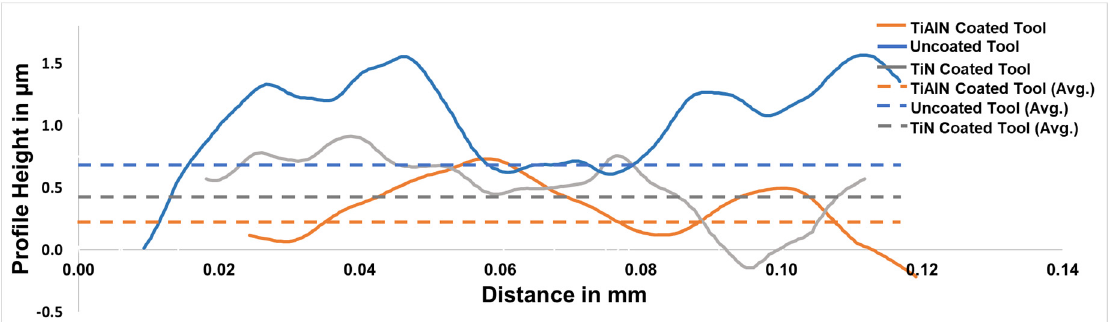
Figure 6. Lateral edge roughness plots for three tool types.